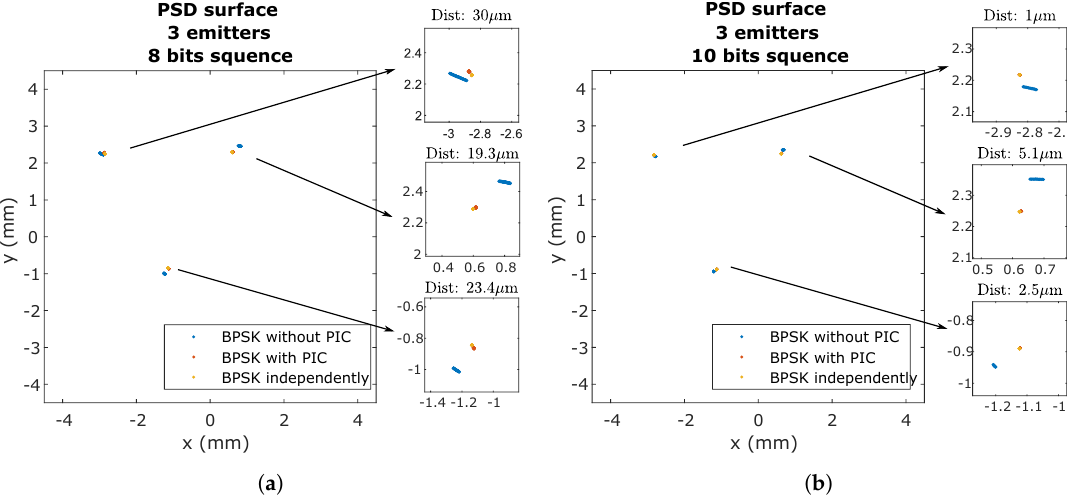
Figure 23. Impact points on the PSD surface using CDMA-BPSK emitted independently, not applied and applying PIC correction with a size of: ( a ) 8 bits; and ( b ) 10